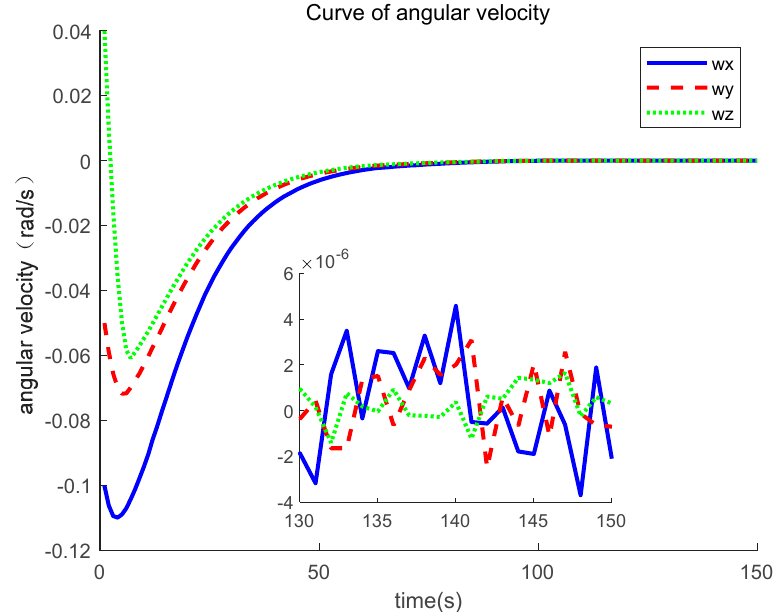
Figure 3. Curve of angular velocity under a finite time controller from [20].